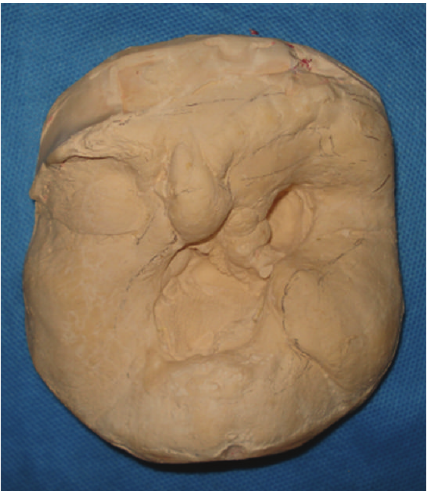
Figure 3: Working